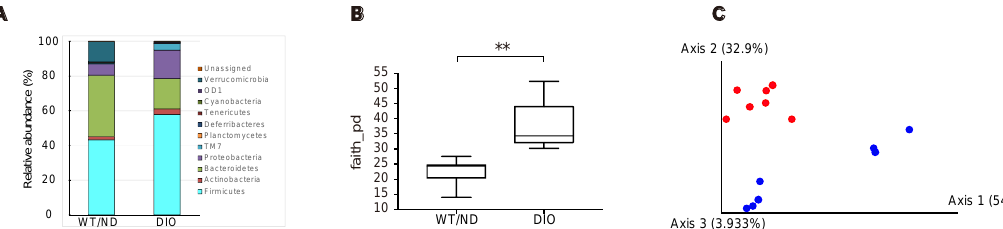
Figure 3. Gut microbial compositions and diversities in DIO and WT/ND mice four weeks after HFD or ND administration. A : Gut microbial compositions based on the relative abundance of OTUs (operational taxonomic units), the units determined by classifying groups of closely related microbiome, at the phylum level from DIO ( n = 7) and WT/ND mice ( n = 7). B : Bacterial alpha diversities for the fecal microbial community using Faith’s phylogenetic alpha diversity index. The p value was calculated using the Kruskal-Wallis test. ** p < 0.01. C : PCoA (principal coordinate analysis) on the weighted UniFrac distance matrices for the microbial community of DIO mice (blue) and WT/ND (red).